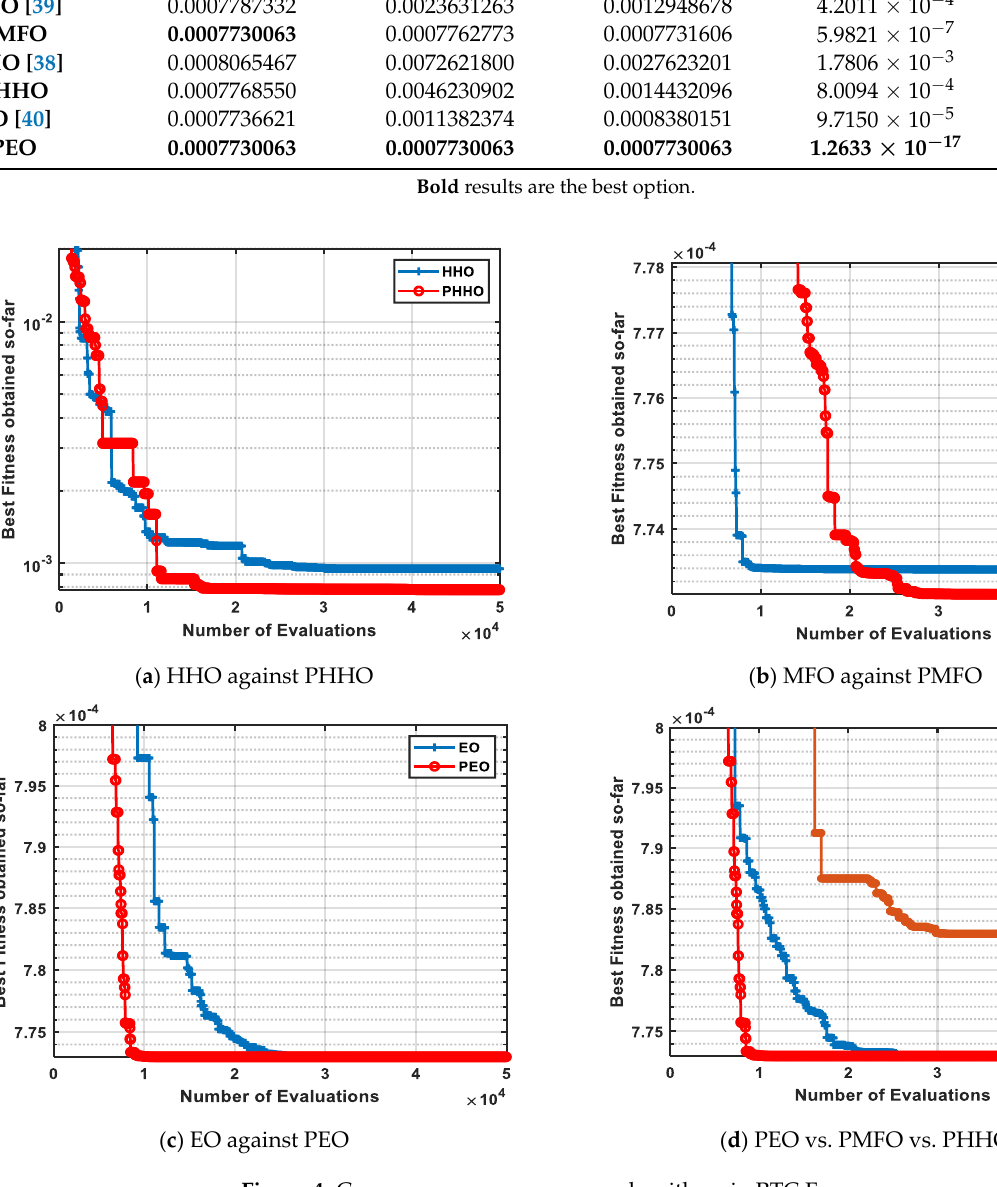
Figure 4. Convergence curves among algorithms in RTC France.